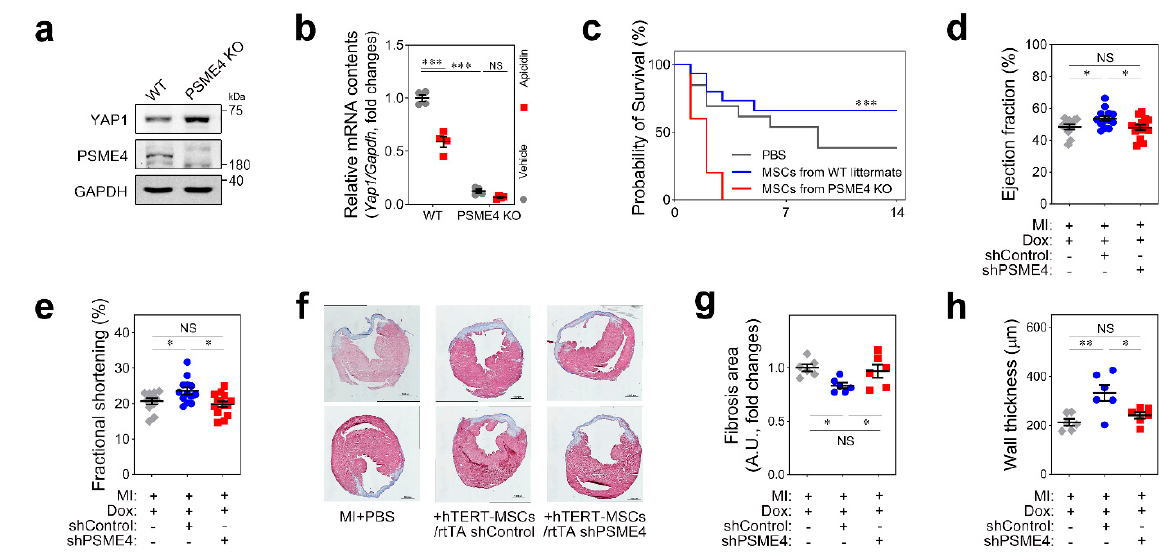
Figure 6. PSME4 governs MSC differentiation via YAP1. ( a ) YAP1 protein was more abundant in primary cultures of MSCs from PSME4-null individuals compared with wildtype littermates. ( b ) Aberrant transcription of YAP1. YAP1 mRNA was significantly lowered in PSME4 knockout (KO) bone marrow (BM) MSCs. ( c ) Survival rate after direct injection of MSCs either from PSME4 KO or wildtype littermate was measured for 2 weeks. When MSCs from PSME4 KO mice were injected, survival was paradoxically decreased. Statistical significance was obtained by applying Mantel–Cox log-rank test. Cohort size: PBS n = 13, MSCs from WT littermate n = 15, MSCs from PSME4 KO n = 10. ( d , e ) Cardiac function, ejection fraction ( d ), and fractional shortening ( e ) were not improved in rtTA-shPSME4 MSCs delivered group. Cohort size: PBS n = 11, MSCs/rtTA shControl n = 13, MSCs/rtTA shPSME4 n = 14. ( f – h ) Cardiac remodeling was not impaired. Cardiac fibrosis ( g , h ) and wall thickness after ischemic insults ( h ) were not improved in the group with PSME4-knockdown hTERT-MSCs injection. Gray rhombus: PBS injection group. Blue circle: rtTA-shControl hTERT-MSCs injection group. Red square: rtTA-shPSME4 hTERT-MSCs delivered group. One-way ANOVA or two-way ANOVA ( c ) with Tukey’s HSD multiple comparison test. * p < 0.05, ** p < 0.01, *** p < 0.001. NS, not significant.